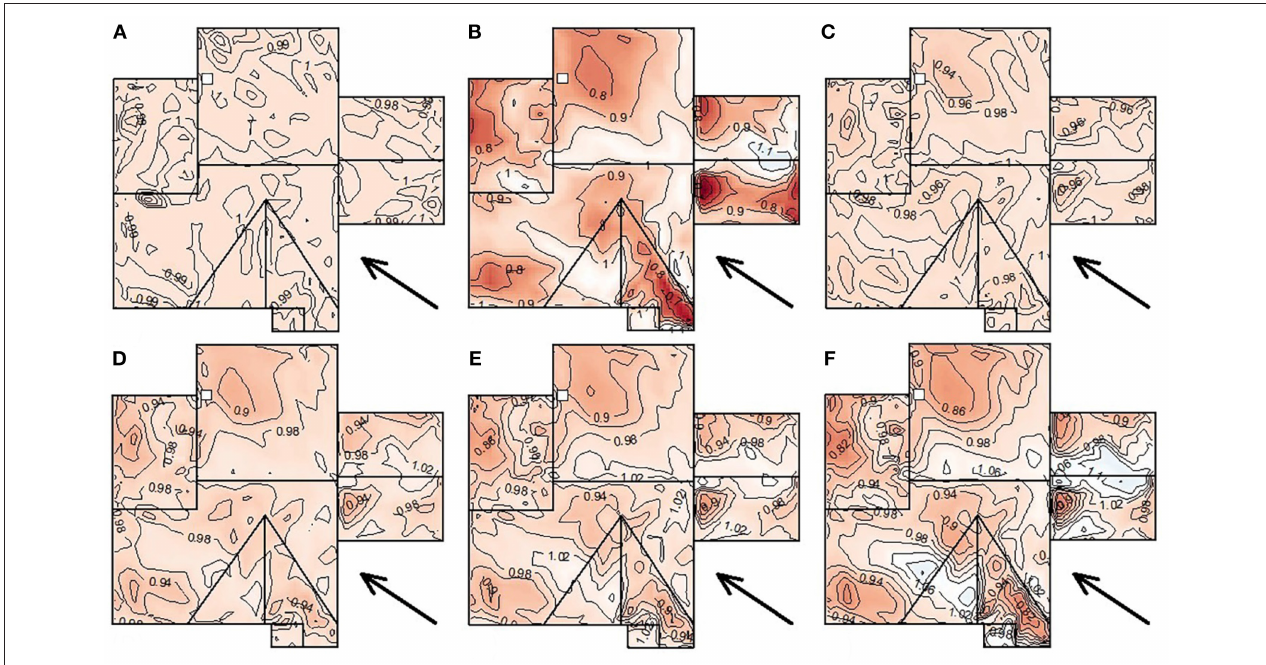
FIGURE 9 | Spatial distribution of the average performance for each method: (A) EVA N = 16 and T = 10min ( N peak = 11), (B) YGP T = 60min ( N peak = 30), (C) XIMIS T = 160min ( N peak = 11), (D) XIMIS T = 60min ( N peak = 30), (E) XIMIS T = 30min ( N peak = 60), (F) XIMIS T = 10min ( N peak = 180).